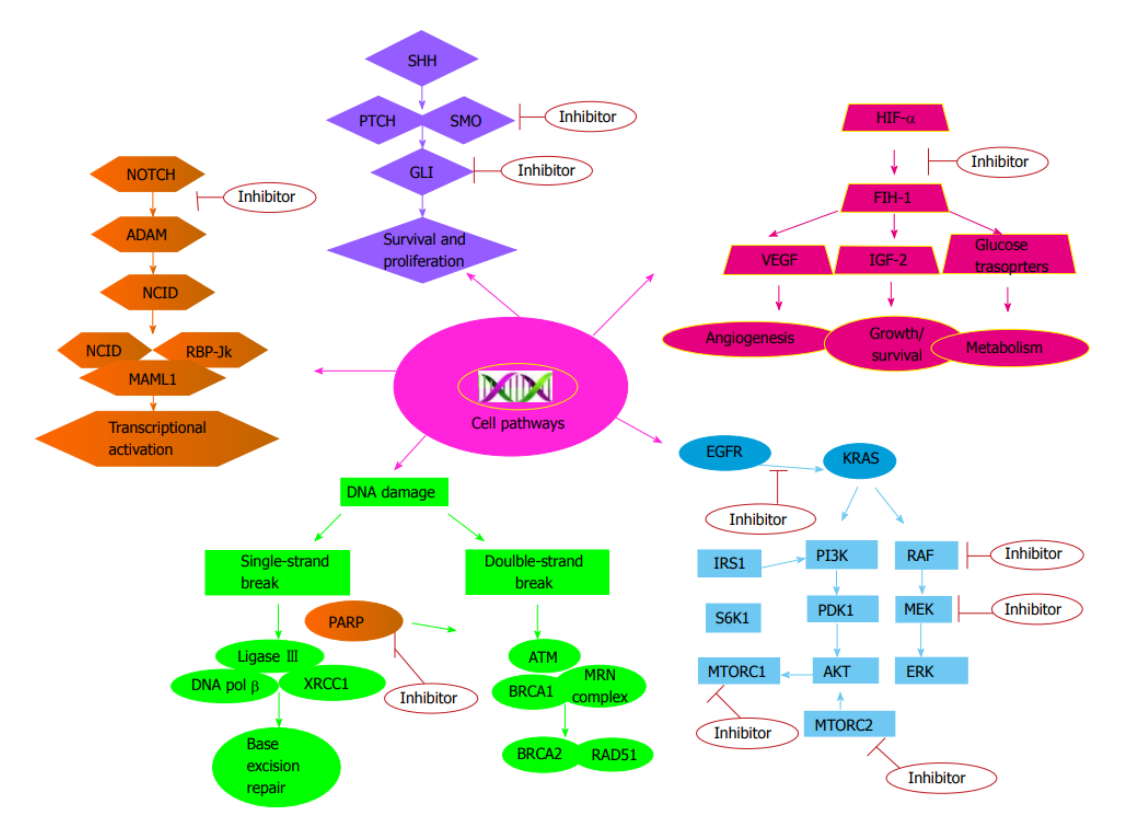
Fig. 11 . Cell signaling pathways involved in pancreatic ductal adenocarcinoma carcinogenesis and actionable molecular targets 59 . Imagine the research necessary to scratch the surface of one type of cancer system . Scientists in developing nations must also ask the hard questions, which require peace of mind, infinite patience, and a sense of purpose, to use science to serve